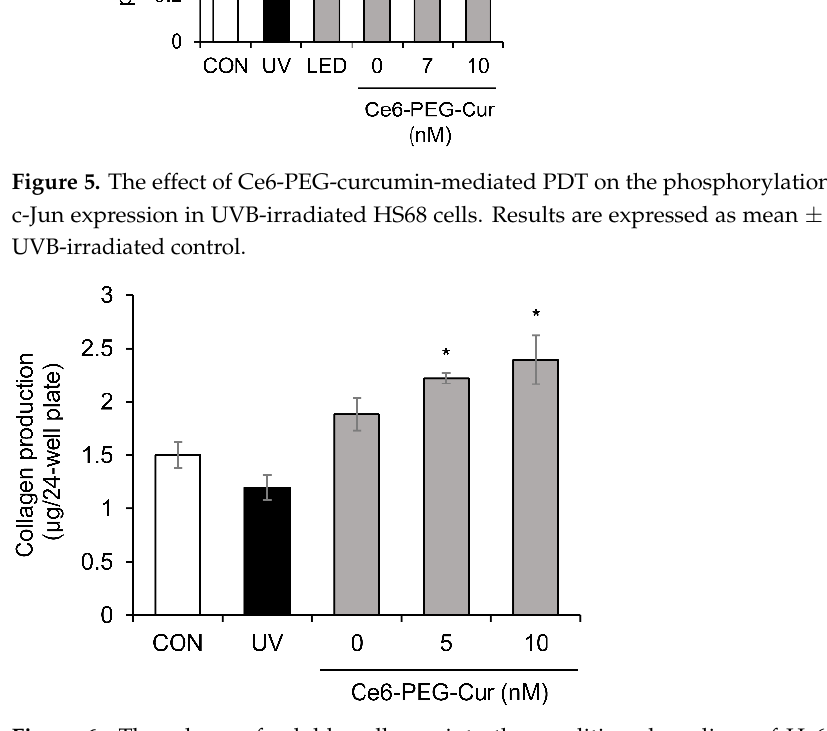
Figure 6. The release of soluble collagen into the conditioned medium of Hs68 fibroblast cells supplied with Ce6-PEG-curcumin-mediated PDT was determined by Sircol collagen assay. Results are expressed as mean ± SD. * p < 0.05 vs. UVB-irradiated control.